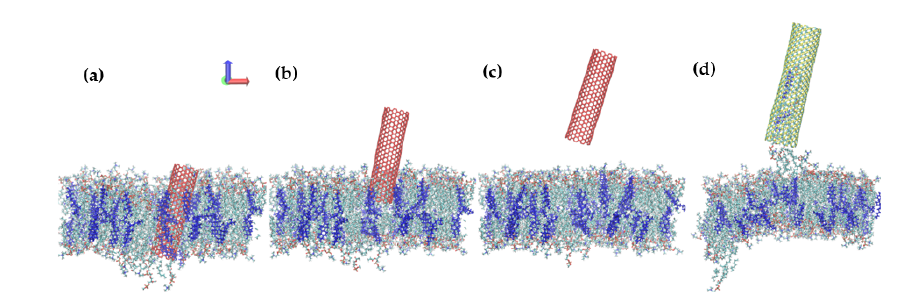
Figure 6. A series of snapshots visualizing tube-axis membrane withdrawal for CNT, 15 ◦ , and v = 2.0 m/s. Cholesterol molecules inside the DMPC membrane are colored dark blue. ( a ) CNT indenter at z = − 55 Å, ( b ) z = − 25 Å, ( c ) z = 5 Å; ( d ) SiCNT indenter at z = 5 Å.